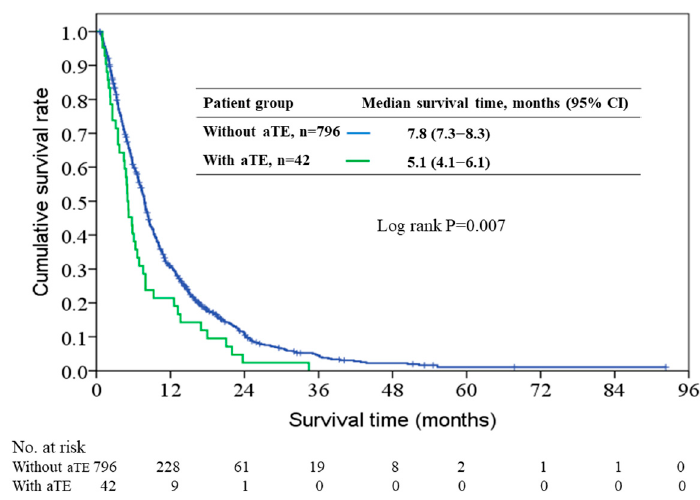
Figure 1. Kaplan–Meier overall survival curves for patients with and without arterial thromboembolism (aTE).